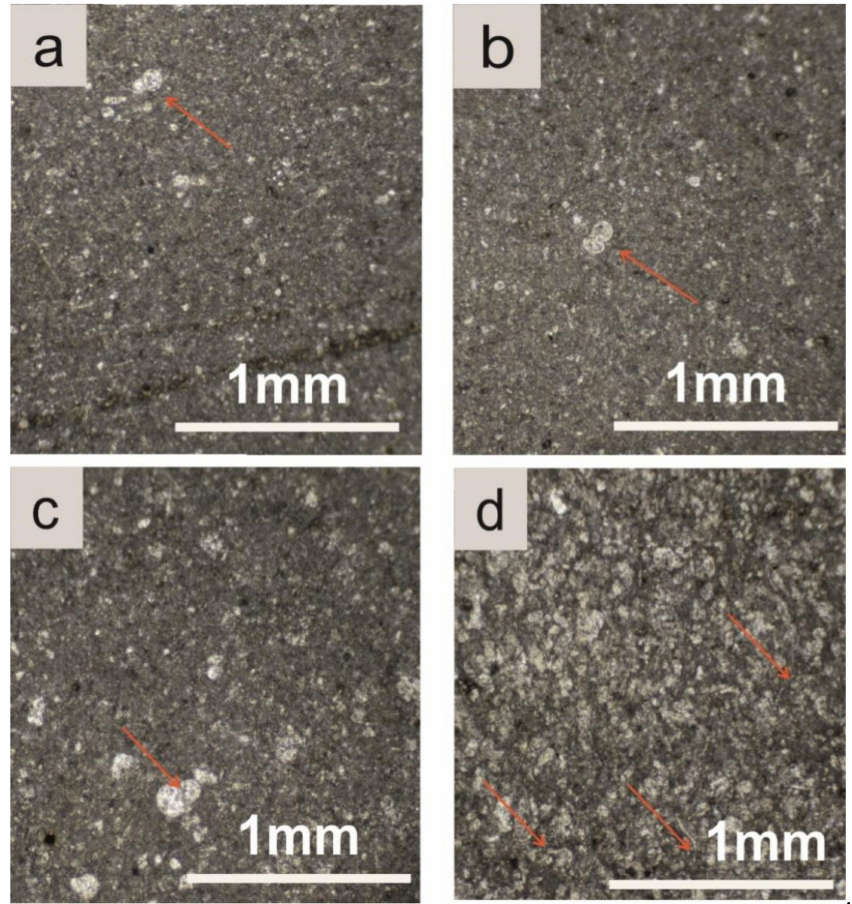
Figure 9. Microfacies type F3: Mudstone/wackestone with planktic foraminifera (red arrow) of Maastrichtian age. ( a ) mudstone with planktic foraminifera (red arrow), sample K9, ( b ) mudstone with planktic foraminifera (red arrow), sample K9, ( c ) mudstone with planktic foraminifera (red arrow), sample K10, ( d ) wackestone with planktic foraminifera (red arrow), sample